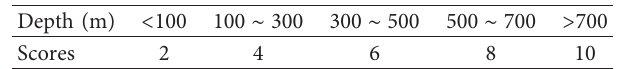
Table 6: The score of the buried